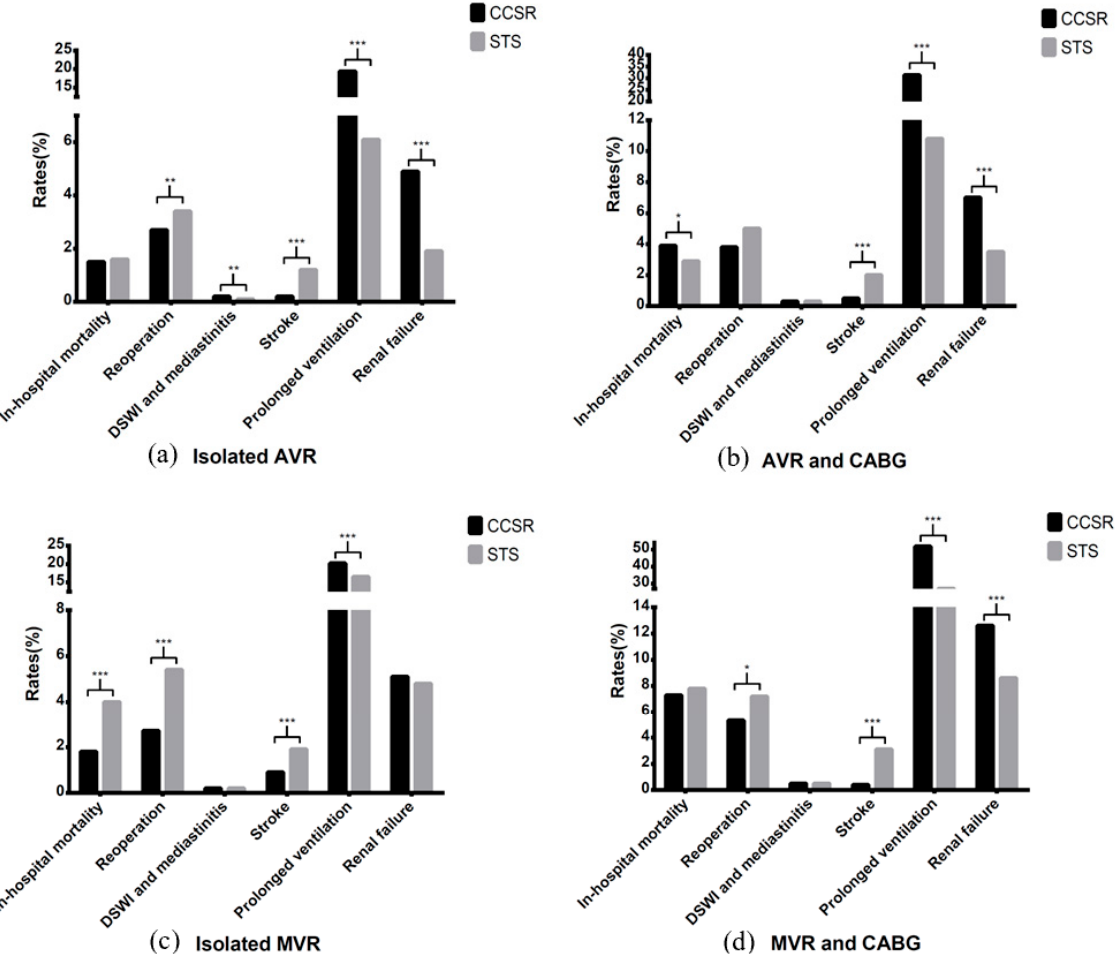
Figure 4. Comparison of outcomes in different procedures between CCSR and STS data. CCSR: Chi ‐ nese Cardiac Surgery Registry; STS: Society of Thoracic Surgeons; AVR: aortic valve replacement; MVR: mitral valve replacement; CABG: coronary artery bypass grafting; DSWI: deep sternal wound infection. *: 0.01 < p ‐ value < 0.05; **: 0.001 < p ‐ value < 0.01; ***: p ‐ value < 0.001.